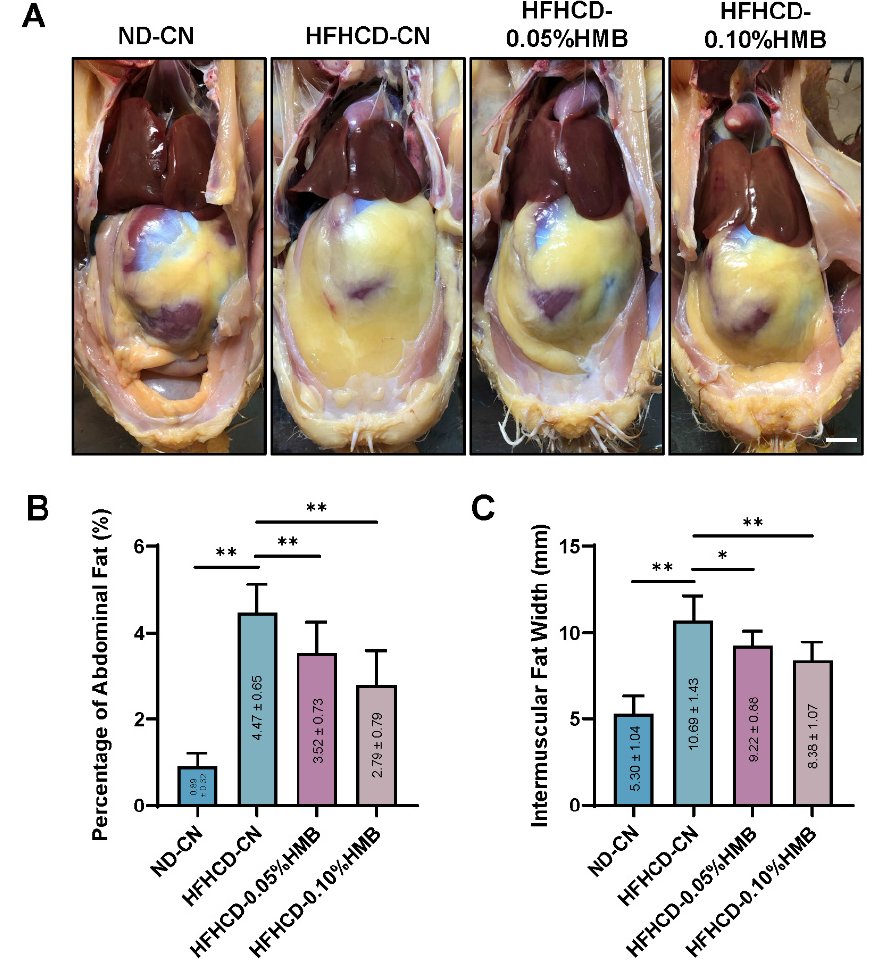
Figure 2. Effects of HMB on fat deposition in HFHCD − challenged layers. ( A ) Representative pictures of layers. Scale bar, 1 cm. ( B ) Percentage of abdominal fat ( n = 10). ( C ) Intermuscular fat width ( n = 10). All the results are shown as the means ± SDs; * p < 0.05, ** p < 0.01.